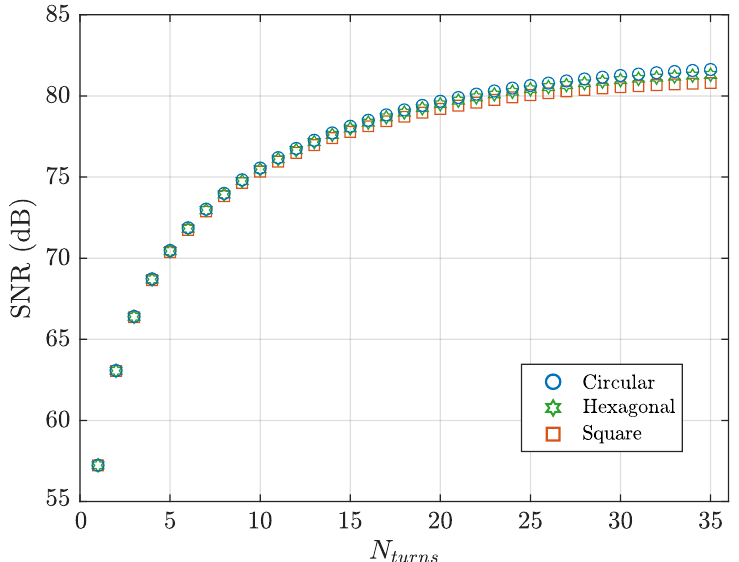
Figure 6. SNR predicted from Equation (23). Circular, hexagonal and square planar coil shapes are compared, with variation in turn count. The three planar coils have the same footprint area (5.85cm 2 ) of a hexagon with a diagonal of 3cm.